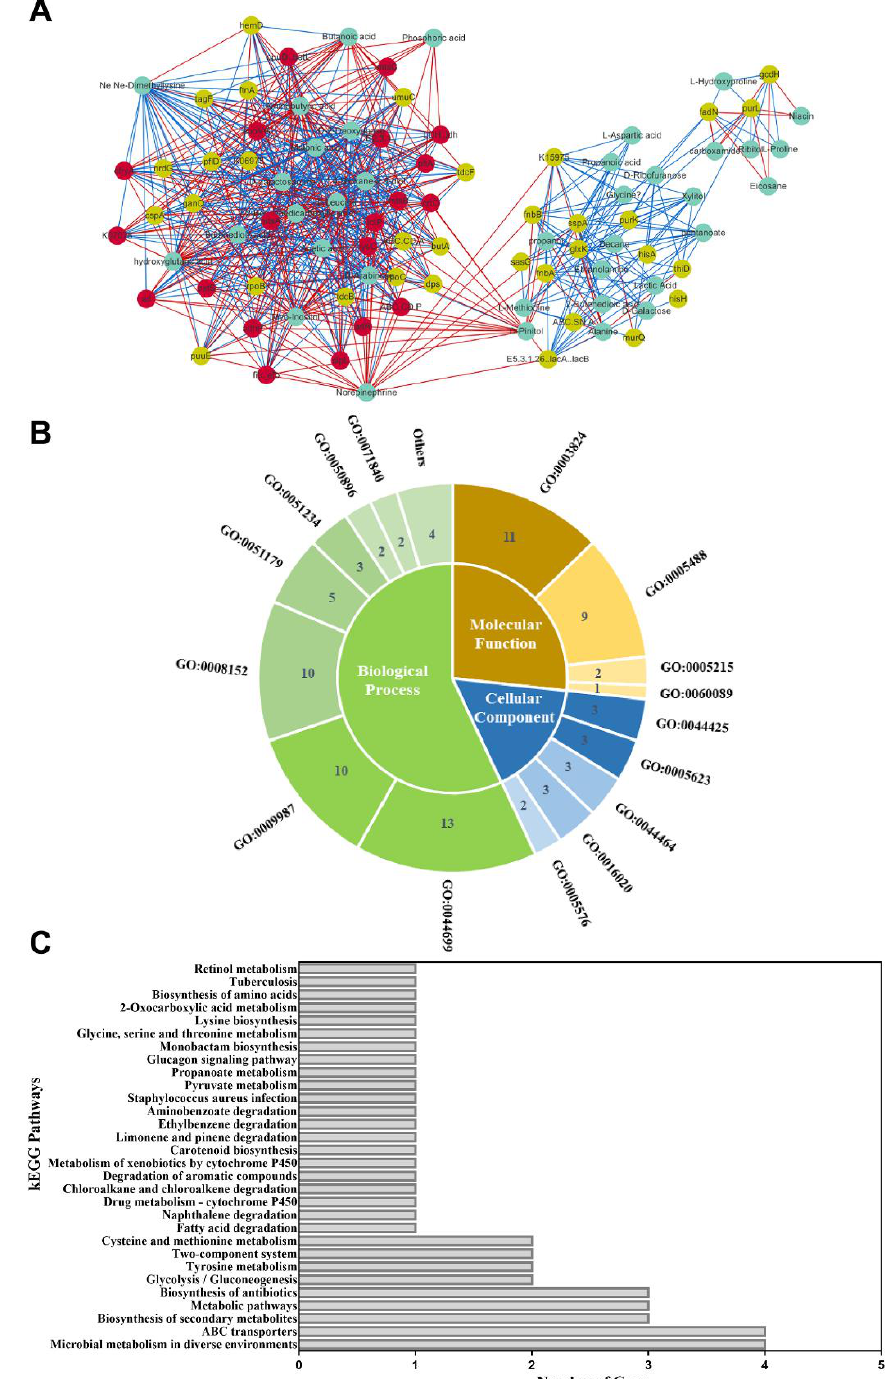
Figure 8. The results of the integration analysis. ( A ) Relational Graph of key candidate genes and DMs. Green node represents DM, yellow node represents candidate gene, and red node represents hub gene. The red and green lines represent positive and negative correlations, respectively. The thicker the line, the larger the correlation coefficient, and the thinner the line, the smaller the correlation coefficient; ( B ) GO functional classification; Biological processes, molecular functions, and cellular components associated with hub genes; ( C ) Pathway analysis of hub genes. The X -axis represents the number of annotated genes. The Y -axis represents the pathway terms.